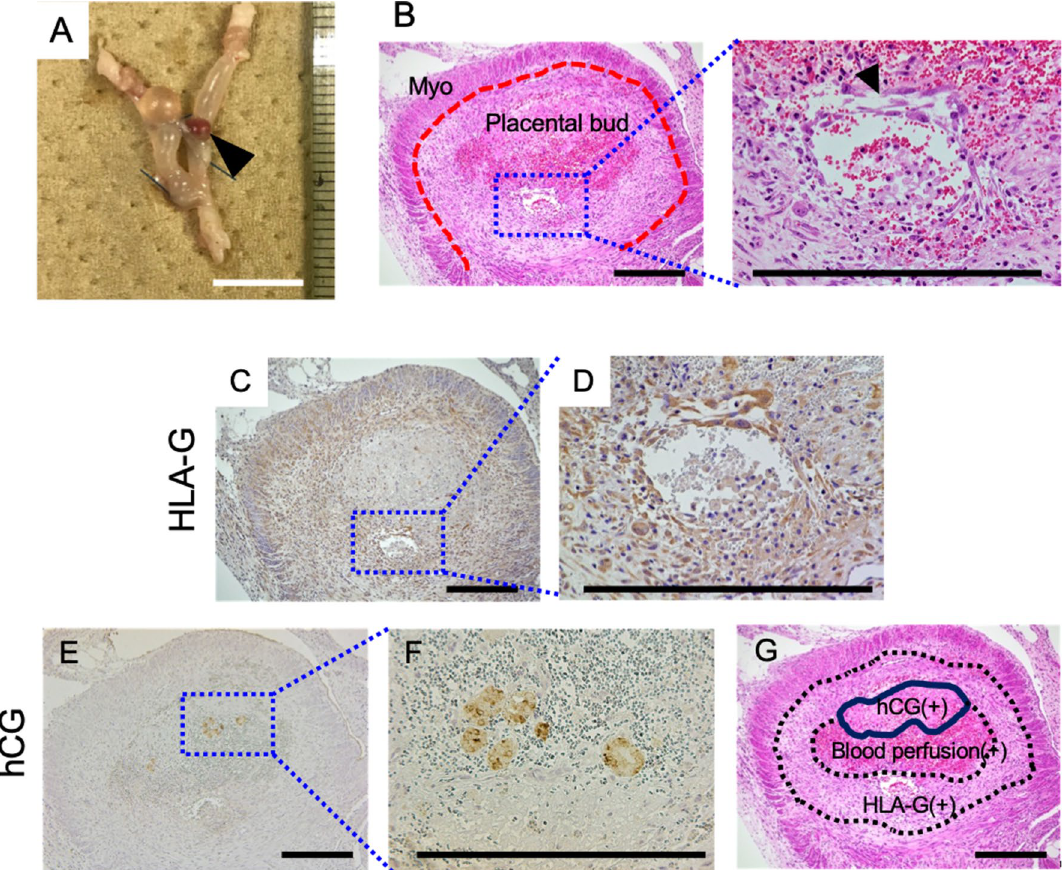
Figure 5. Trophoblast layers forming in the transplanted placental organ bud. Histological examination of case 2. ( A ) Macroscopic image of the transplanted organ bud in the NOD/SCID mouse uterus (case 2). A black arrow head indicates the bud. Bar, 1 mm. ( B ) H&E staining of case 2. Lower (left) and higher magnification (right). Black arrow head indicates the vascular-like structure inside the organ bud. ( C , D ) Immunohistochemistry of HLA-G. ( C ) Lower magnification (middle), and ( D ) higher magnification of the vasculature-like structure. ( E , F ) Immunohistochemistry of hCG. ( E ) Lower and ( F ) higher magnification. ( G ) Scheme of the trophoblast layers and blood-perfused area in the organ bud. All bars, 300